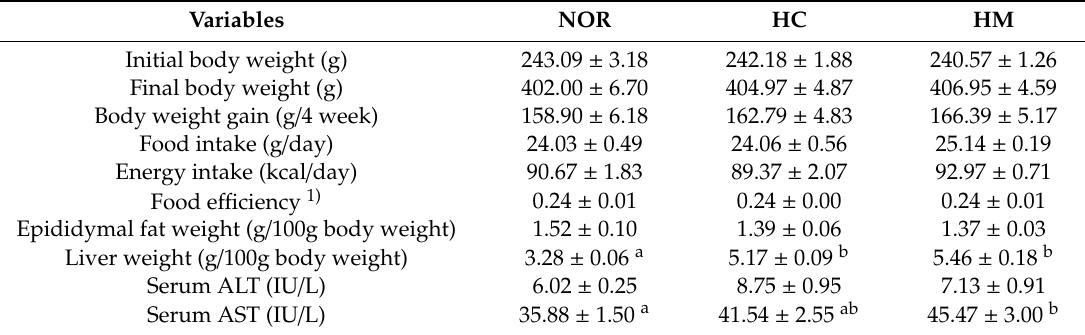
Table 1. E ff ect of mulberry fruit extract on physiological